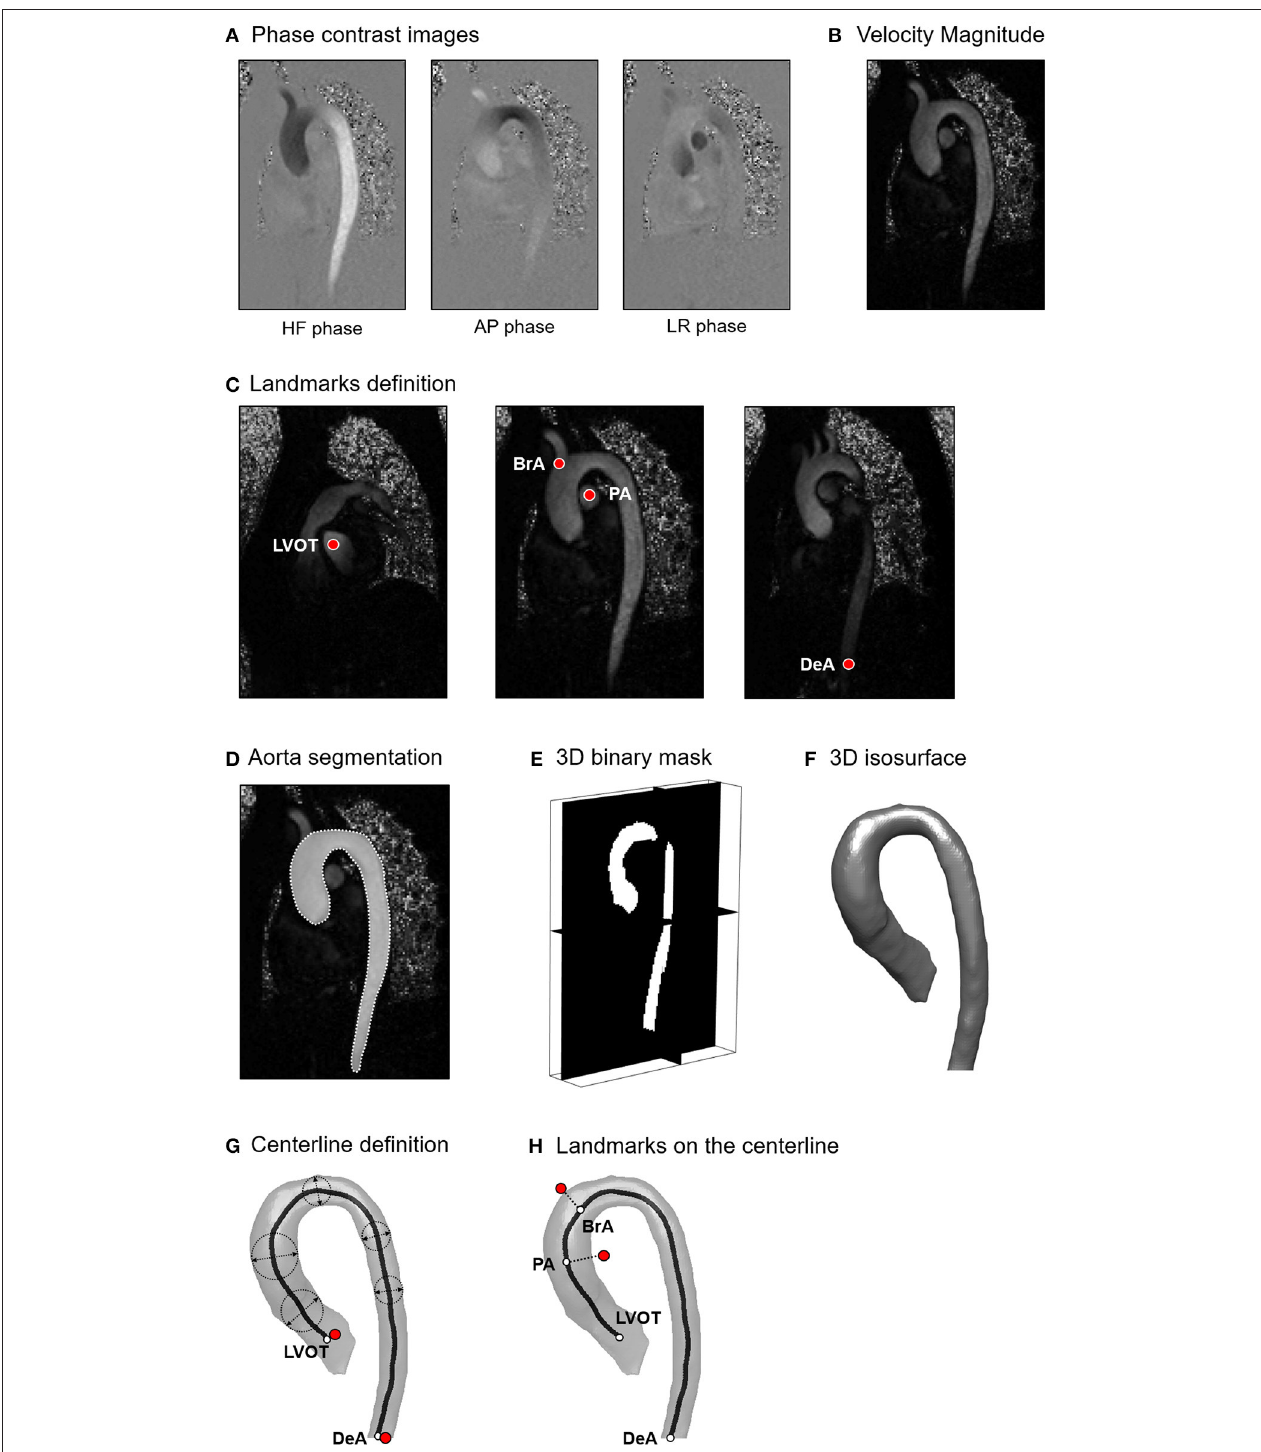
FIGURE 1 | (A) Phase contrast images encoded for Head-Foot (HF), Antero-Posterior (AP) and Left-Right (LR) directions; (B) Magnitude intensity of the velocity vector computed as the Euclidean norm of the 3D velocity vectors. (C) Definition of anatomically relevant landmarks of the aortic lumen: left ventricle outflow tract (LVOT), brachiocephalic artery (BrA), right pulmonary artery (PA), distal point of the descending aorta (DeA); (D) Tracing of the aortic lumen boundaries; (E) 3D binary mask obtained from the stack of manually traced slices; (F) 3D isosurface of the aortic lumen; (G) Computation of the vessel centerline; (H) Projection of the identified landmarks on the